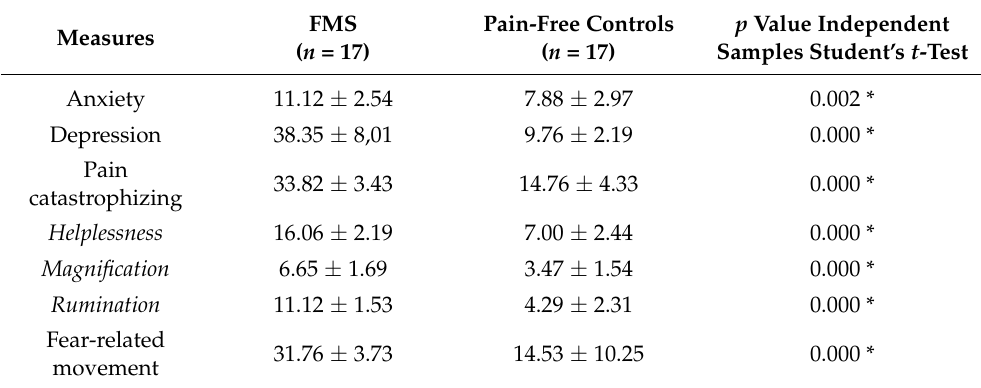
Table 3. Between-group comparison of psychological